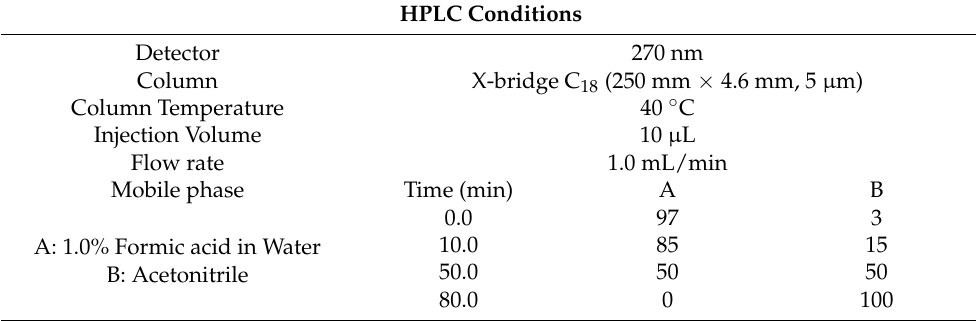
Table 3. HPLC conditions for